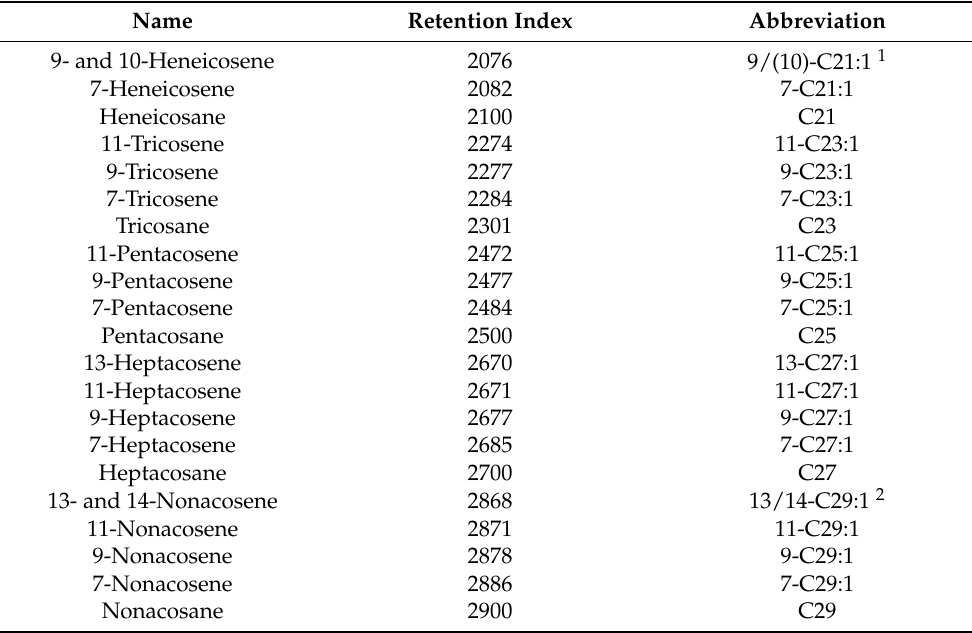
Table 1. List of all components found and analyzed at the cuticula of male and female specimens of T. cyanea , with their retention index and